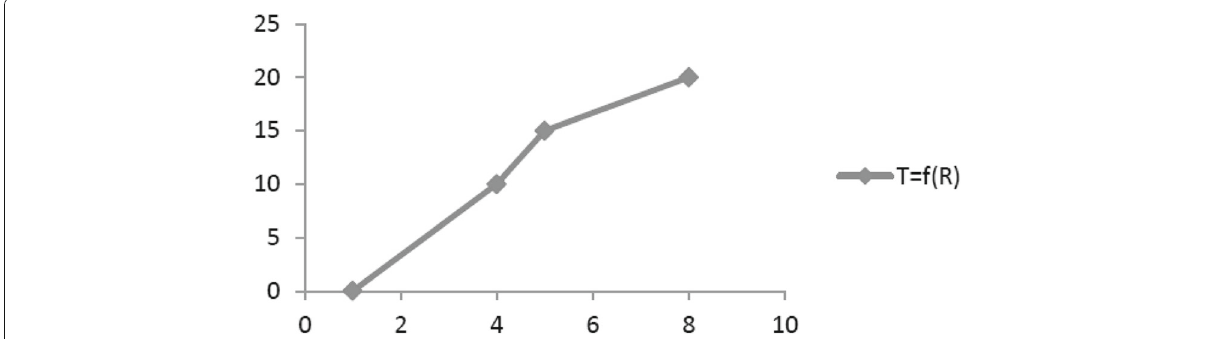
Fig. 5 A char of function T = f ( R